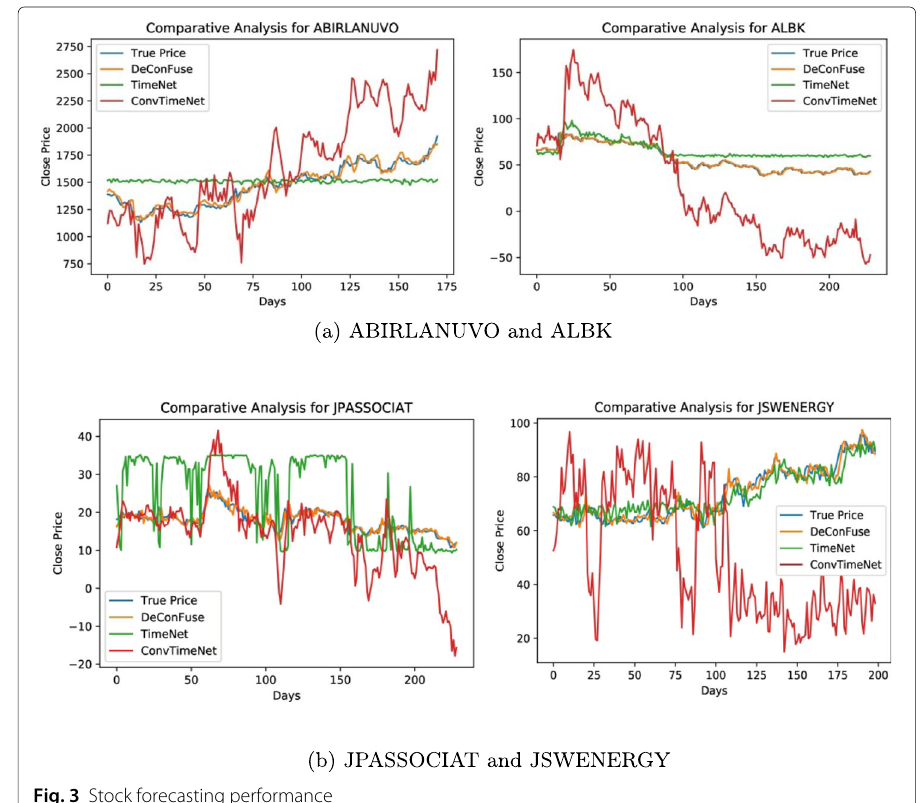
Fig. 3 Stock forecasting performance